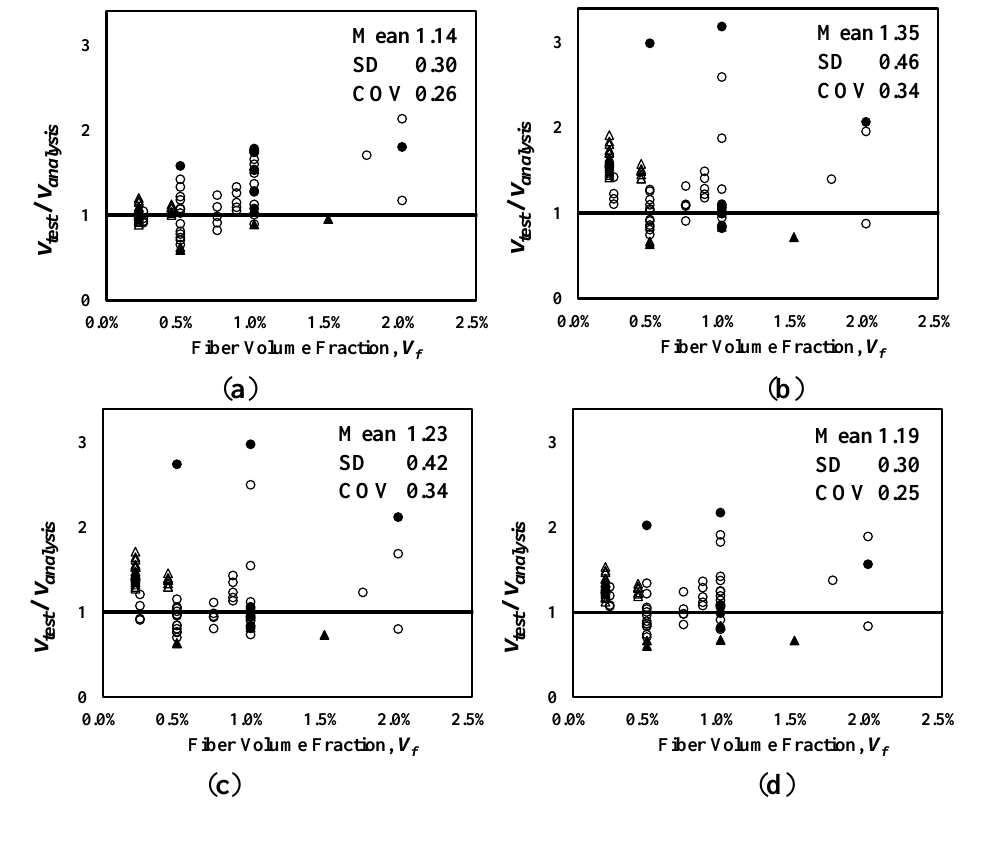
Table 2. Comparison of analysis